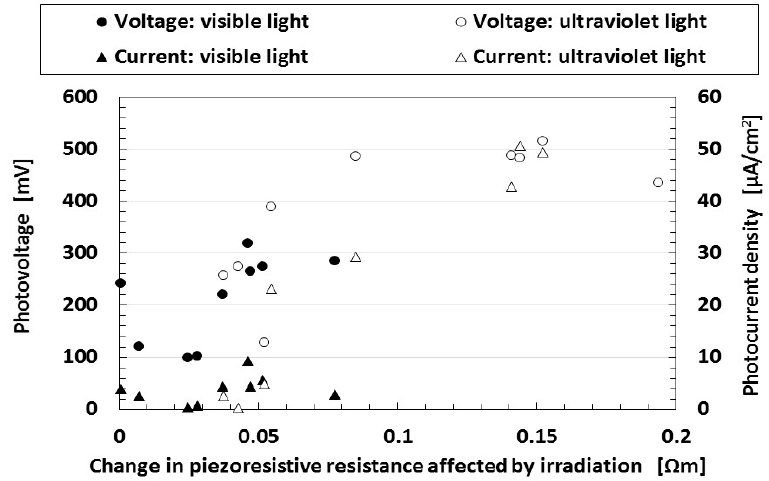
Figure 3. Change in photoelectricity under visible and ultraviolet light on the different kinds of dyes used for wet-type MCF rubber solar cell electrolytically polymerized under a magnetic field. The abscissa in the figure presents the change in the apparent resistance by irradiation.